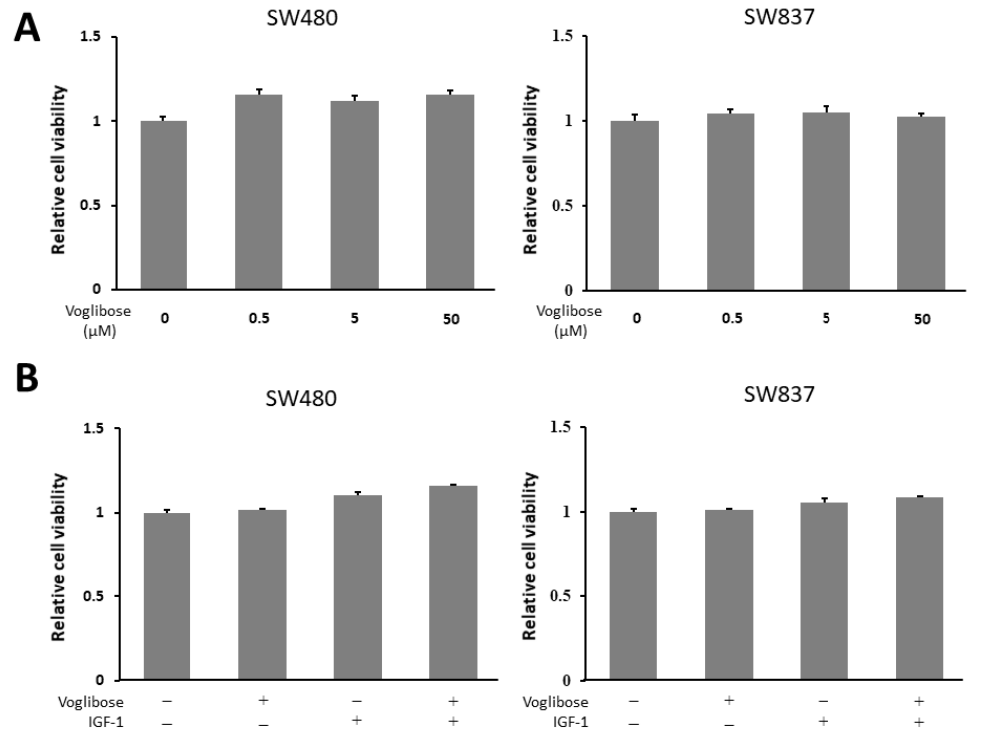
Figure 6. Effects of voglibose on cellular proliferation in SW480 and SW837 cells. ( A ) Cell proliferation assay of SW480 and SW837 cells treated with different levels of voglibose after 72-h in vitro incubation. ( B ) Cell proliferation assay of SW480 and SW837 cells treated with voglibose (50 µM) and/or IGF-1 (10 nM) after 72-h incubation. Data represent means ± S.E. from the various experimental groups. IGF-1, insulin-like growth factor -1.